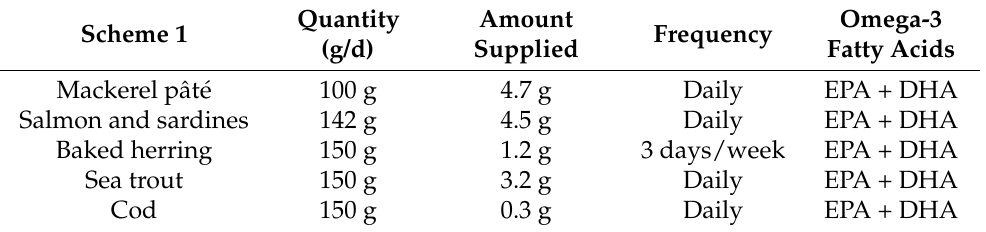
Table 1. In order to supply 250 mg/d of EPA and DHA (for prophylactic purposes), one should eat [54].